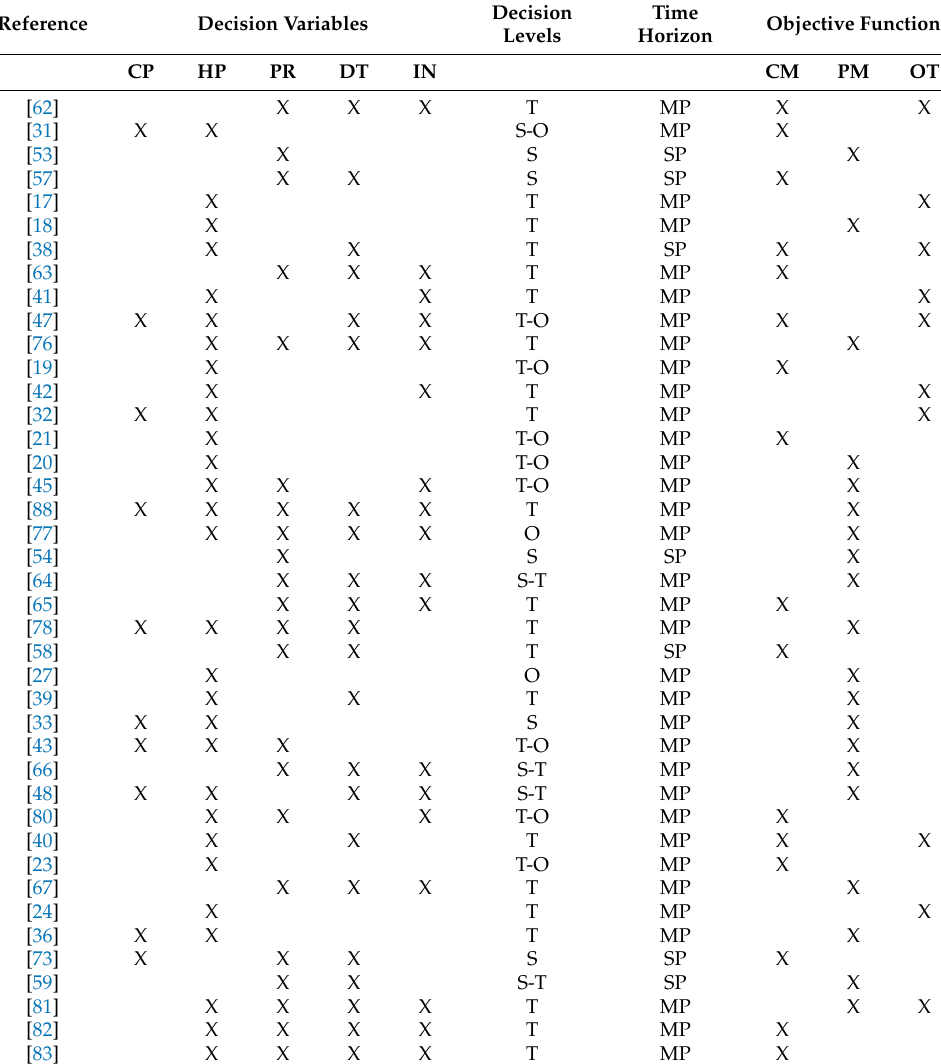
Table 2. Classification according to problem